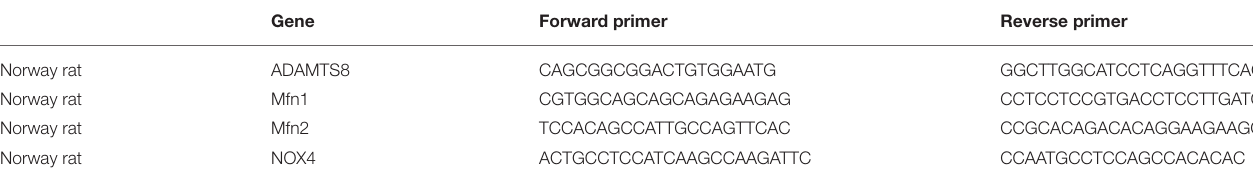
TABLE 1 | Primers sequences used for qRT-PCR.